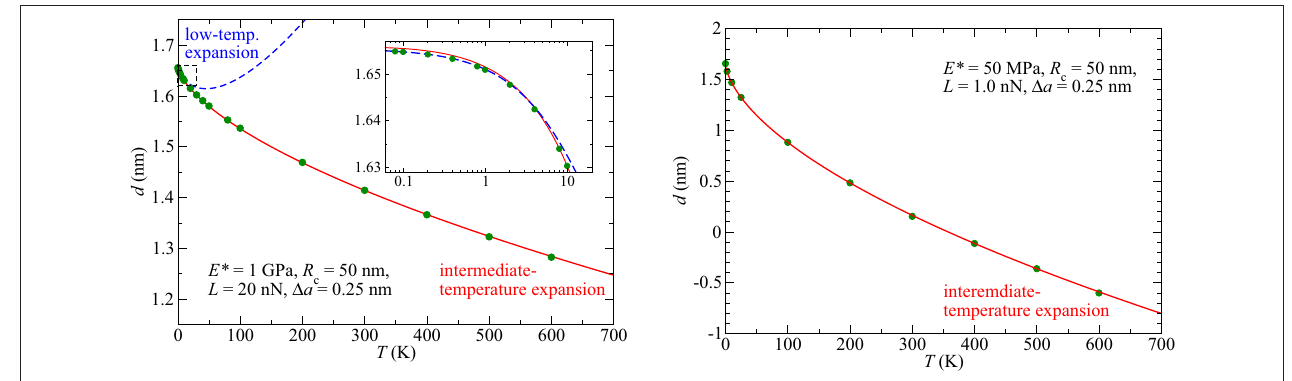
1 GPa) and a soft-matter ( right , E ∗ 50 MPa) system. = =